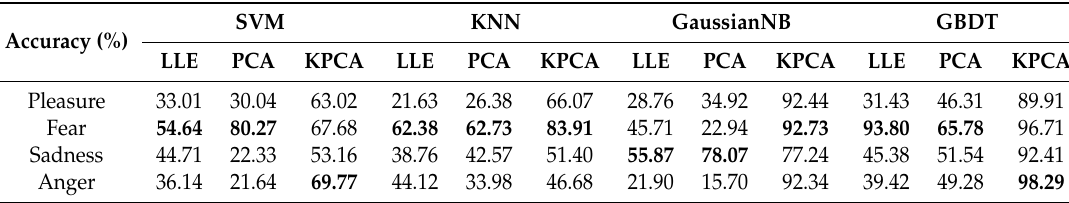
Table 6. Classification results of different emotions.